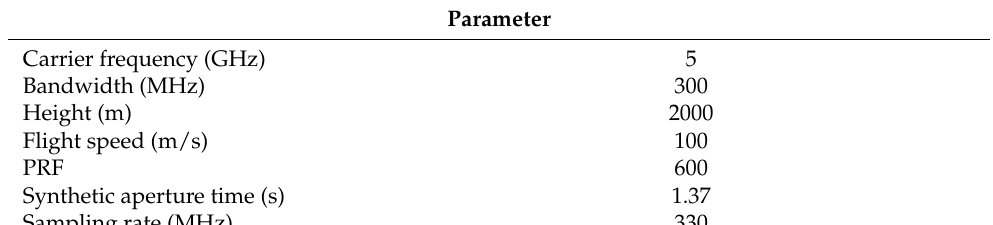
Table 2. Area target simulation scene parameters.